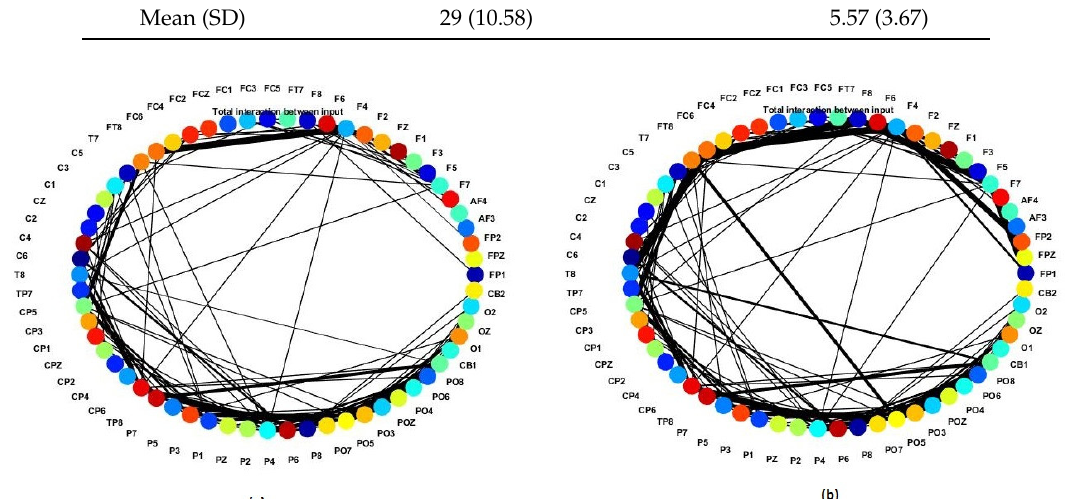
Figure A1. The feature interaction network (FIN) captured the total spike interaction between the areas in the SNN models representing 62 EEG channels as input neurons during the STDP learning for ( a ) the experimental group’s responses toward target stimuli at T1 (before mindfulness training); ( b ) the experimental group’s responses toward target stimuli at T2 (after mindfulness training). FIN nodes represent the input neuronal areas of the SNN model and lines represent the amount of spike transmission between these areas (clusters) of neurons that correspond to the input neurons (EEG channels). The thicker the lines indicate the higher number of spikes exchanged between them.